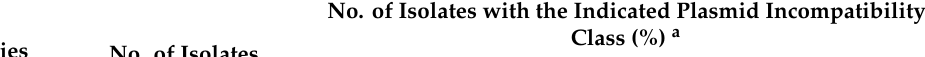
Table 1. Comparison of prevalence and distribution of pESA3 / pCTU1 (incFIB), pESA2 / pCTU2 (incF2), and pCTU3 (incH1) plasmids among 570 Cronobacter isolates.